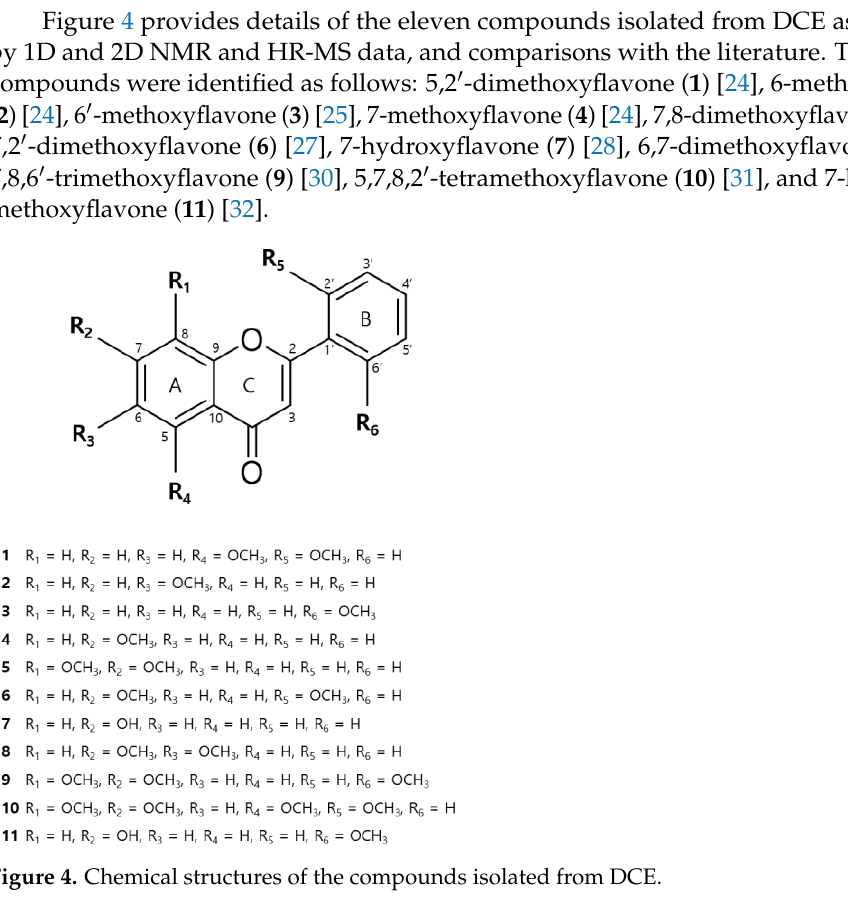
Figure 3. Effect of D. costaricensis EtOH extract (DCE) on toluidine blue staining findings and mast cell numbers in dermal tissues. ( A ) Toluidine blue staining results. ( B ) Mast cell numbers in dermal tissue. CON group: vehicle controls, OX group: oxazolone-treated controls, DCE group: oxazolone plus 1% DCE-treated, and Dexa group: oxazolone plus 0.1% dexamethasone-treated. Data values are expressed as means ± SEMs. # p < 0.05 vs. the CON group, * p < 0.05 vs. the OX group.